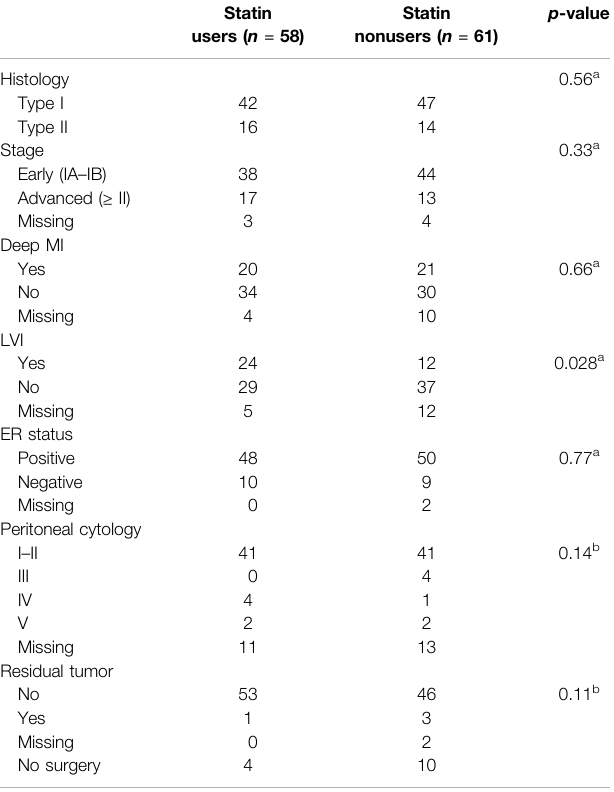
TABLE 2 | Tumor characteristics in statin users and